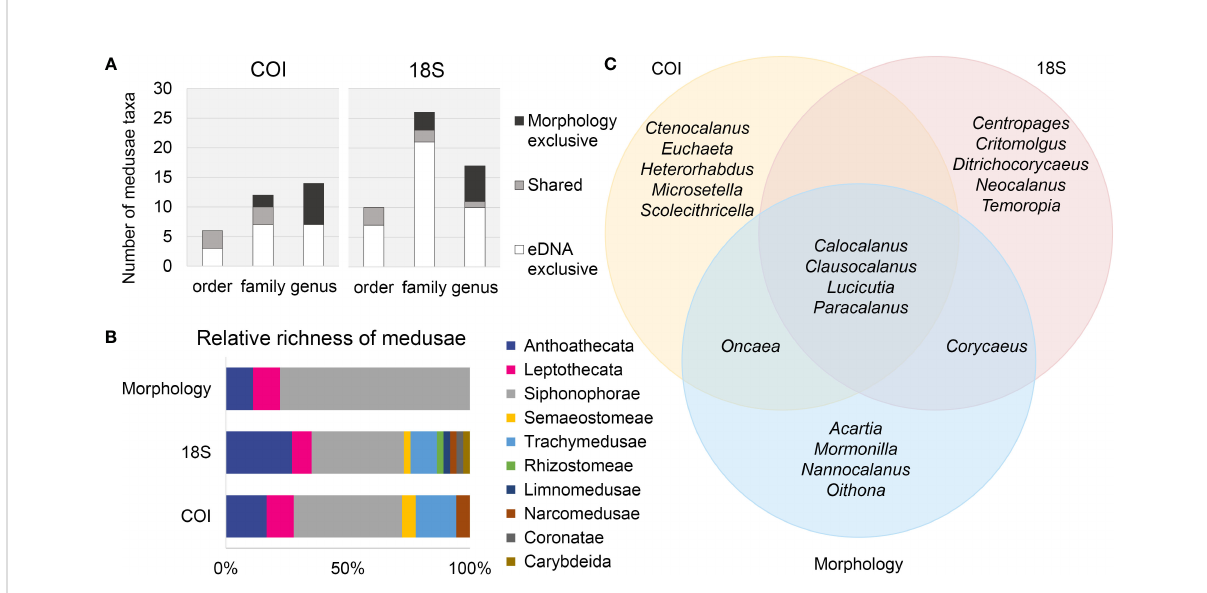
FIGURE 4 Comparison of biodiversity detected by different methods. (A) Numbers of medusae taxa detected per taxonomic level with eDNA metabarcoding (COI and 18S) only, morphology only, or shared by both methods. (B) Relative richness (unique lowest-level taxa) of medusae (Hydrozoa, Scyphozoa, Cubozoa, Staurozoa) at order level identi fi ed by eDNA metabarcoding (COI and 18S) and morphology. (C) Venn diagram of the top-10 most dominant copepods genera (by abundance) detected with eDNA metabarcoding (COI and 18S) and